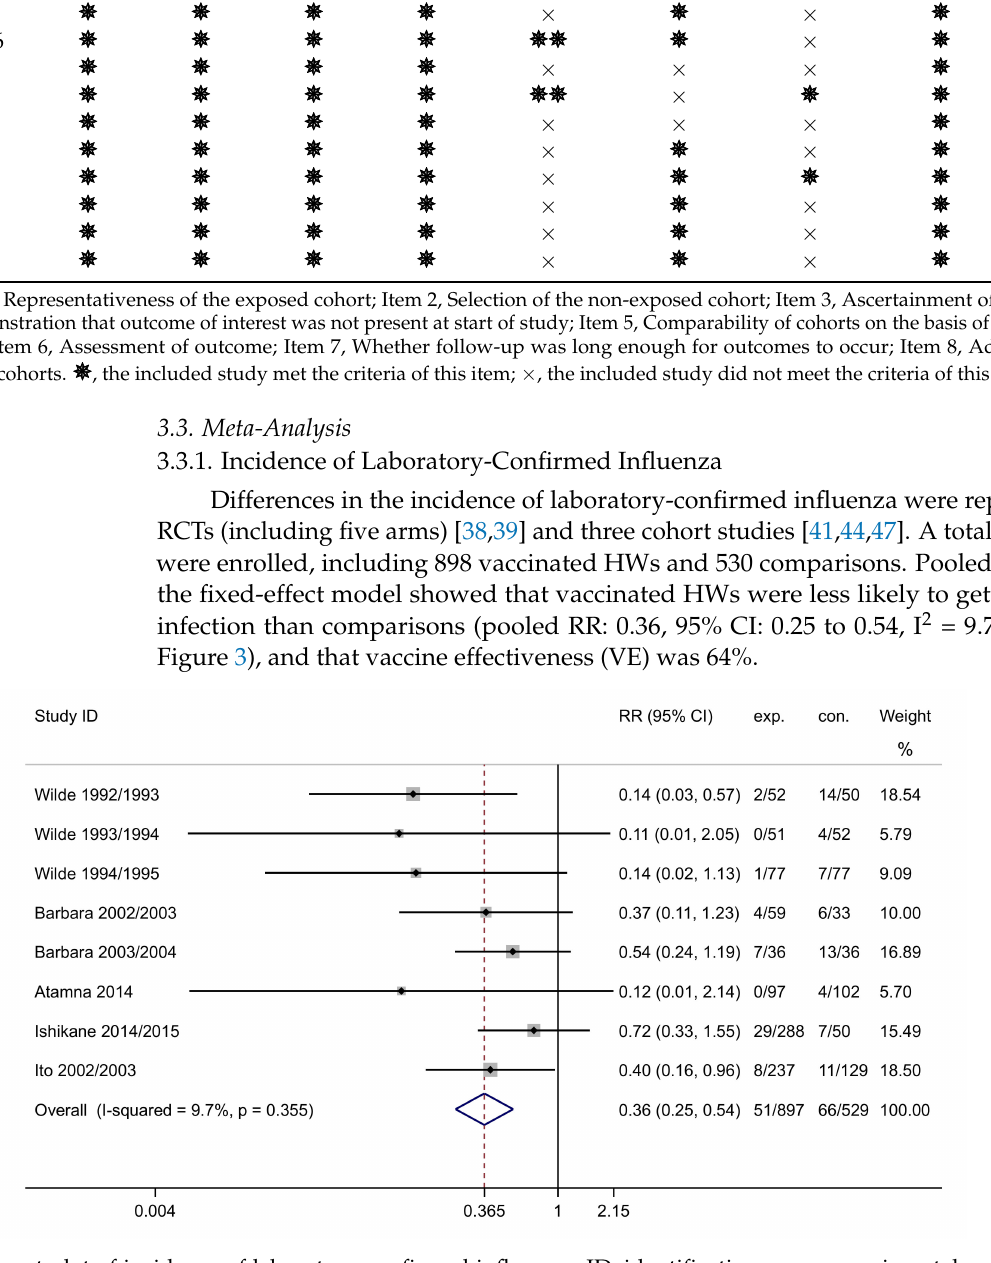
Figure 3. Forest plot of incidence of laboratory-confirmed influenza. ID, identification; exp., experimental group; con., control group; RR, risk